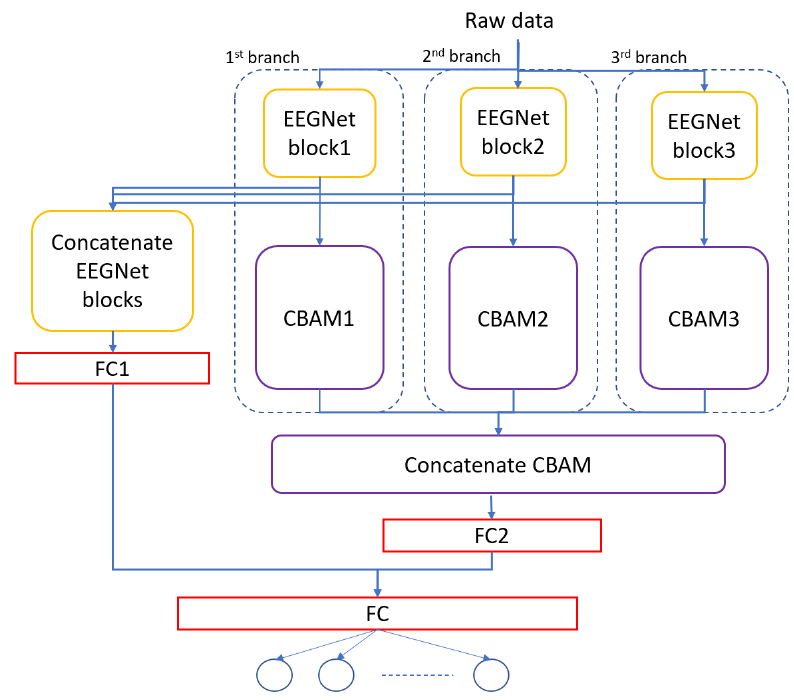
Figure 6. Architecture of the proposed model, FMBEEGCBAM.